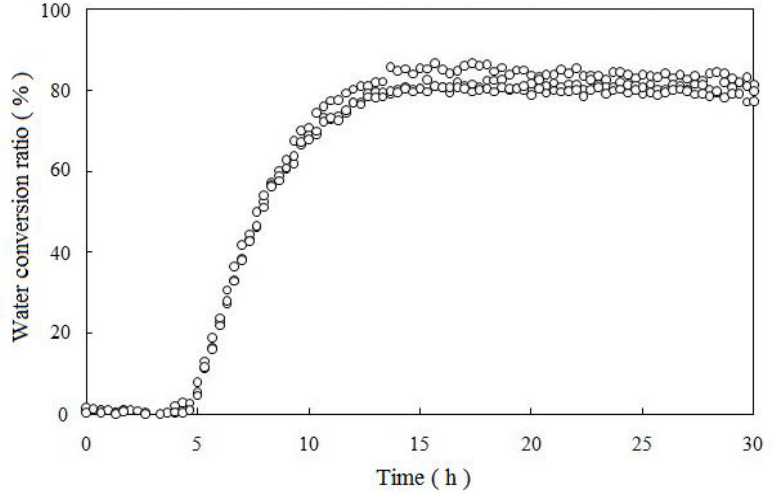
Figure 6. Amplitudes of the 5–9 h period in Figure 4 (for the compact linear